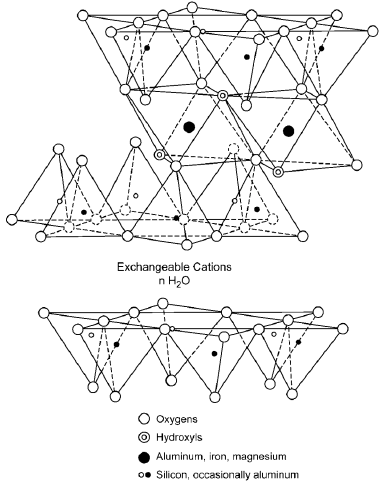
Figure 2. Schematic diagram of smectite structure [21].